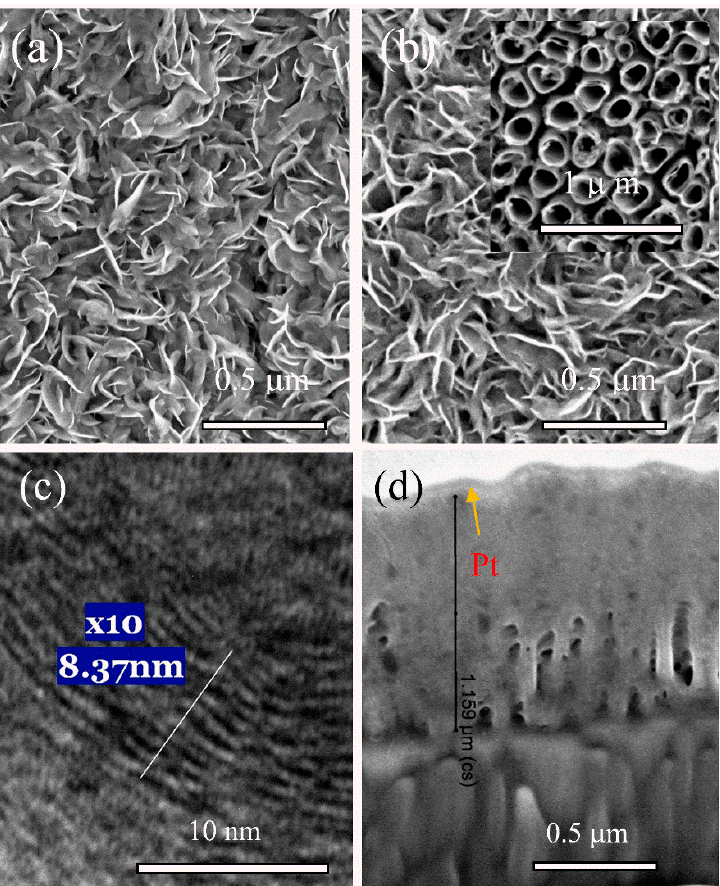
Figure 1. Top-side ( a , b ) and cross-sectional ( d ) scanning electron microscopy (SEM) and high- resolution transmission electron microscopy (HRTEM) ( c ) images of film synthesized hydrothermally on the natotubed titania surface (inset) from the solution containing 5.0 (NH 4 ) 6 Mo 7 O 24 4H 2 O, 90 thiourea without ( a ) and containing 2.0 mmo L − 1 L-cysteine ( b – d ) at 220 ° C for 5 h.